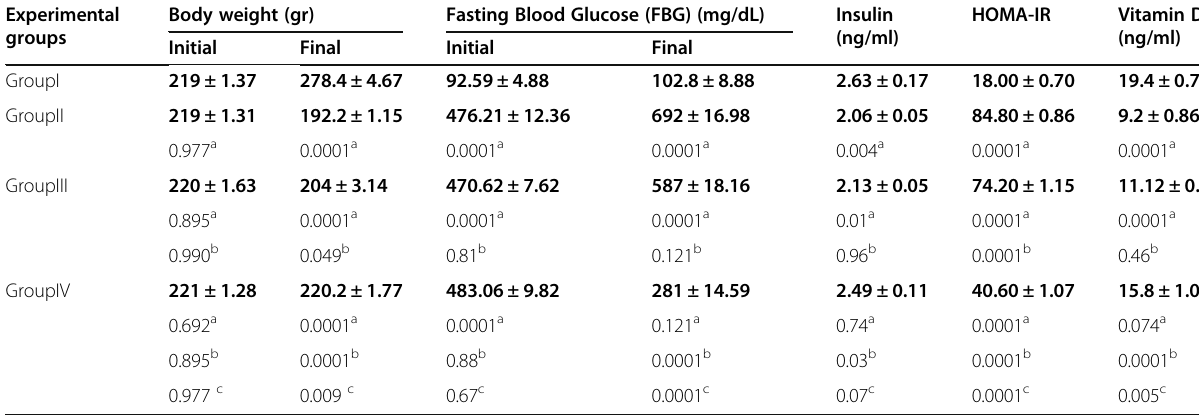
Table 1 Effect of AuNPs on biochemical parameters of experimental groups Experimental groups